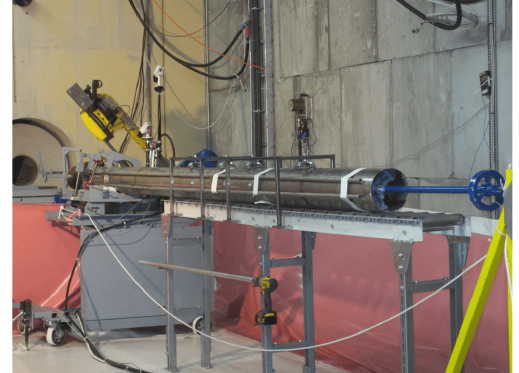
FIG. 18. Extraction of the original dump core and beam pipe from the dump cavity and on top of the structure with rollers. The blue clamping tool is visible on the right.